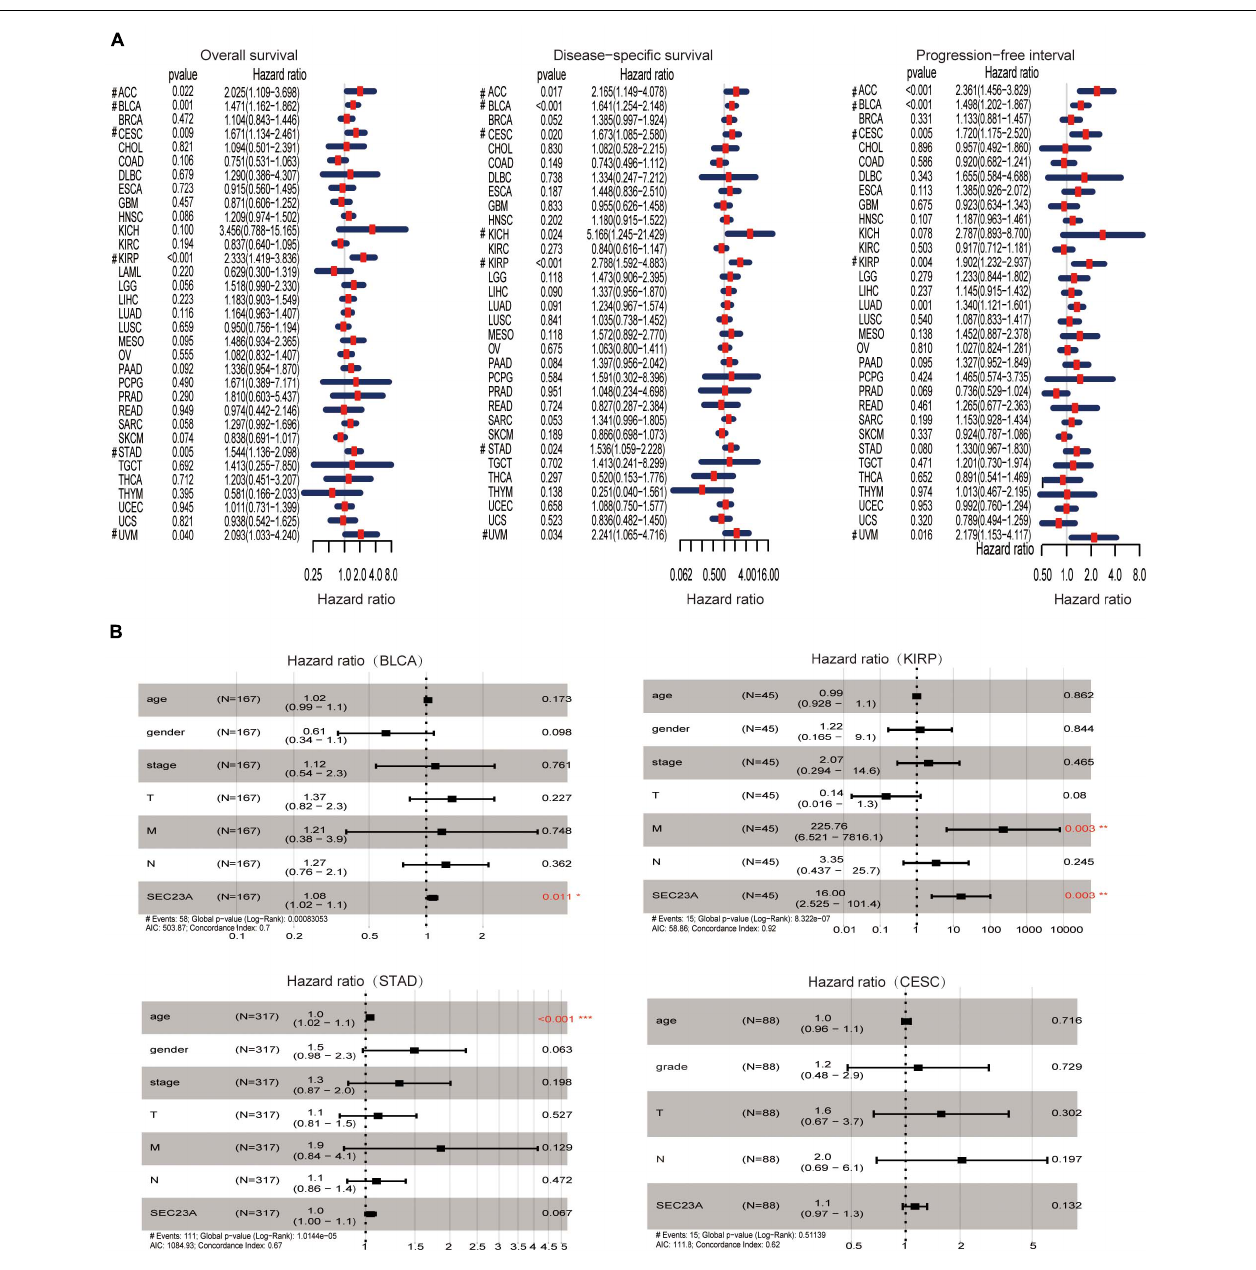
FIGURE 1 | Prognostic value of SEC23A in pan-cancer patients and Multivariate Cox analysis in BLCA, KIRP, STAD, and CESC. (A) Univariate analysis of SEC23A in Pan-cancer patients (OS, DSS, and PFI; p < 0.05). (B) Multivariate Cox analysis of SEC23A expression and other clinical-pathological data (* p < 0.01; ** p < 0.01; and *** p <